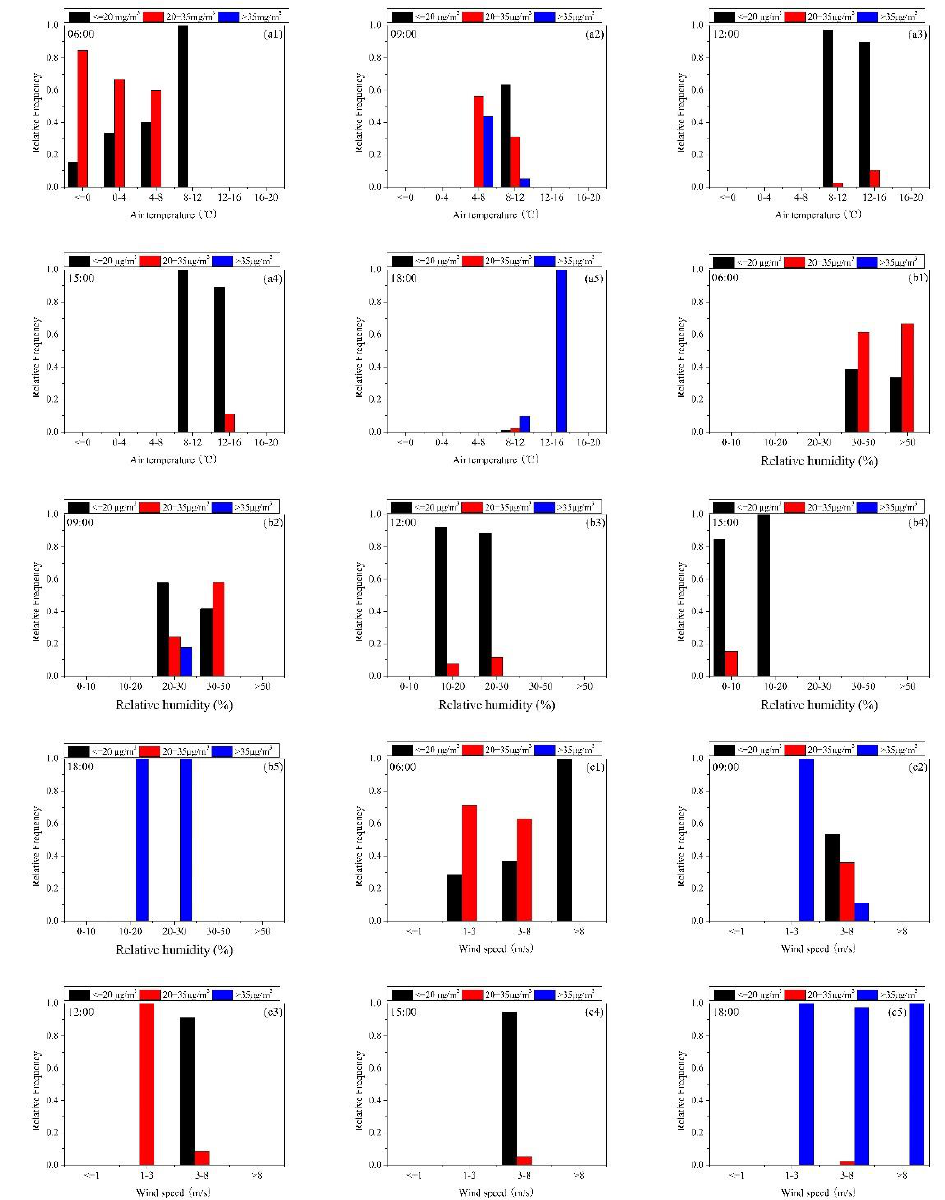
Figure 9. Histograms of the air temperature ( a1 : 06:00, a2 : 09:00, a3 : 12:00, a4 : 15:00, and a5 : 18:00), relative humidity ( b1 : 06:00, b2 : 09:00, b3 : 12:00, b4 : 15:00, and b5 : 18:00), and wind speed ( c1 : 06:00, c2 : 09:00, c3 : 12:00, c4 : 15:00, and c5 : 18:00) for different PM concentrations (black columns are ≤ 20 µ g · m − 3 , red columns are 20–35 µ g · m − 3 , blue columns are > 35 µ g · m − 3 ) during the observation periods at Tazhong.